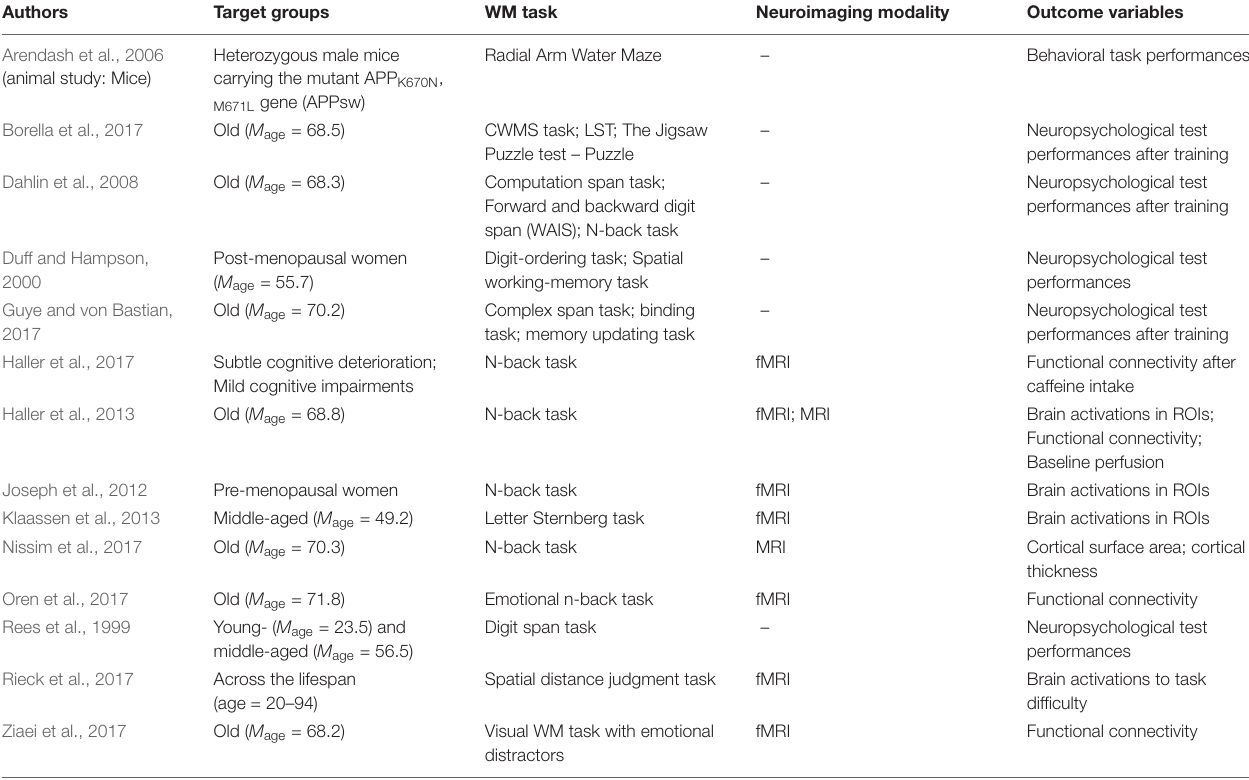
TABLE 2 | Working memory (WM) studies in relation to age.